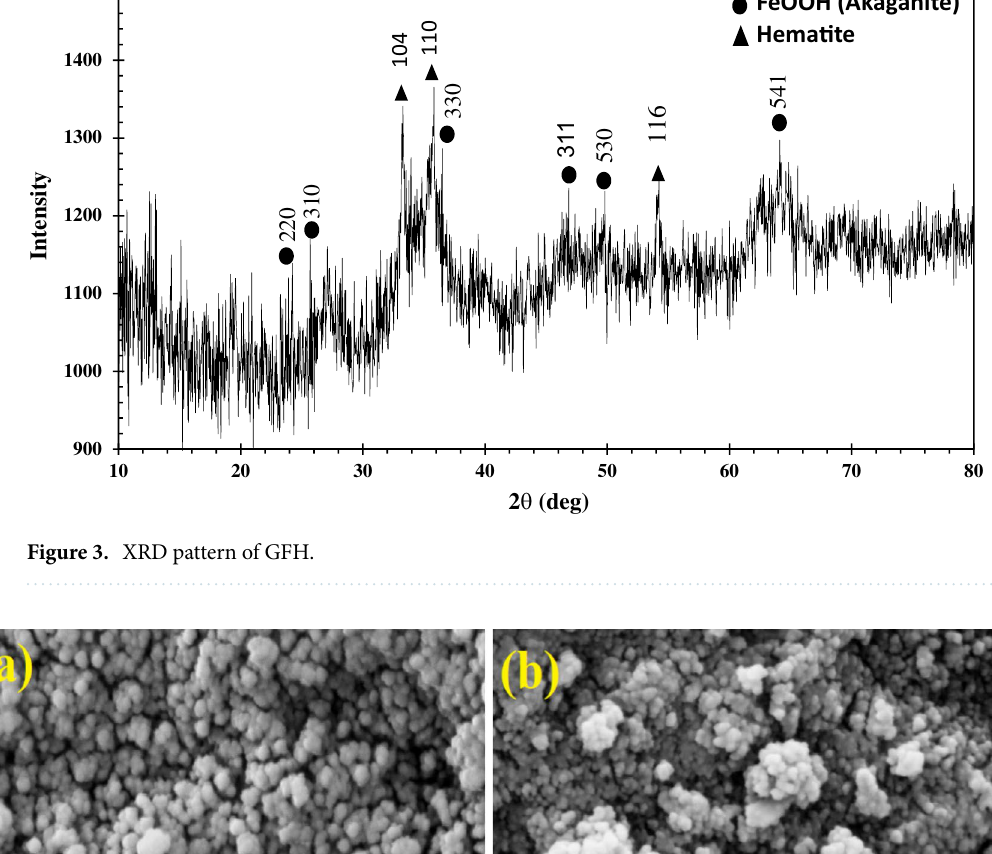
Figure 4. GFH FESEM ( a ). Raw ( b ). After AR18